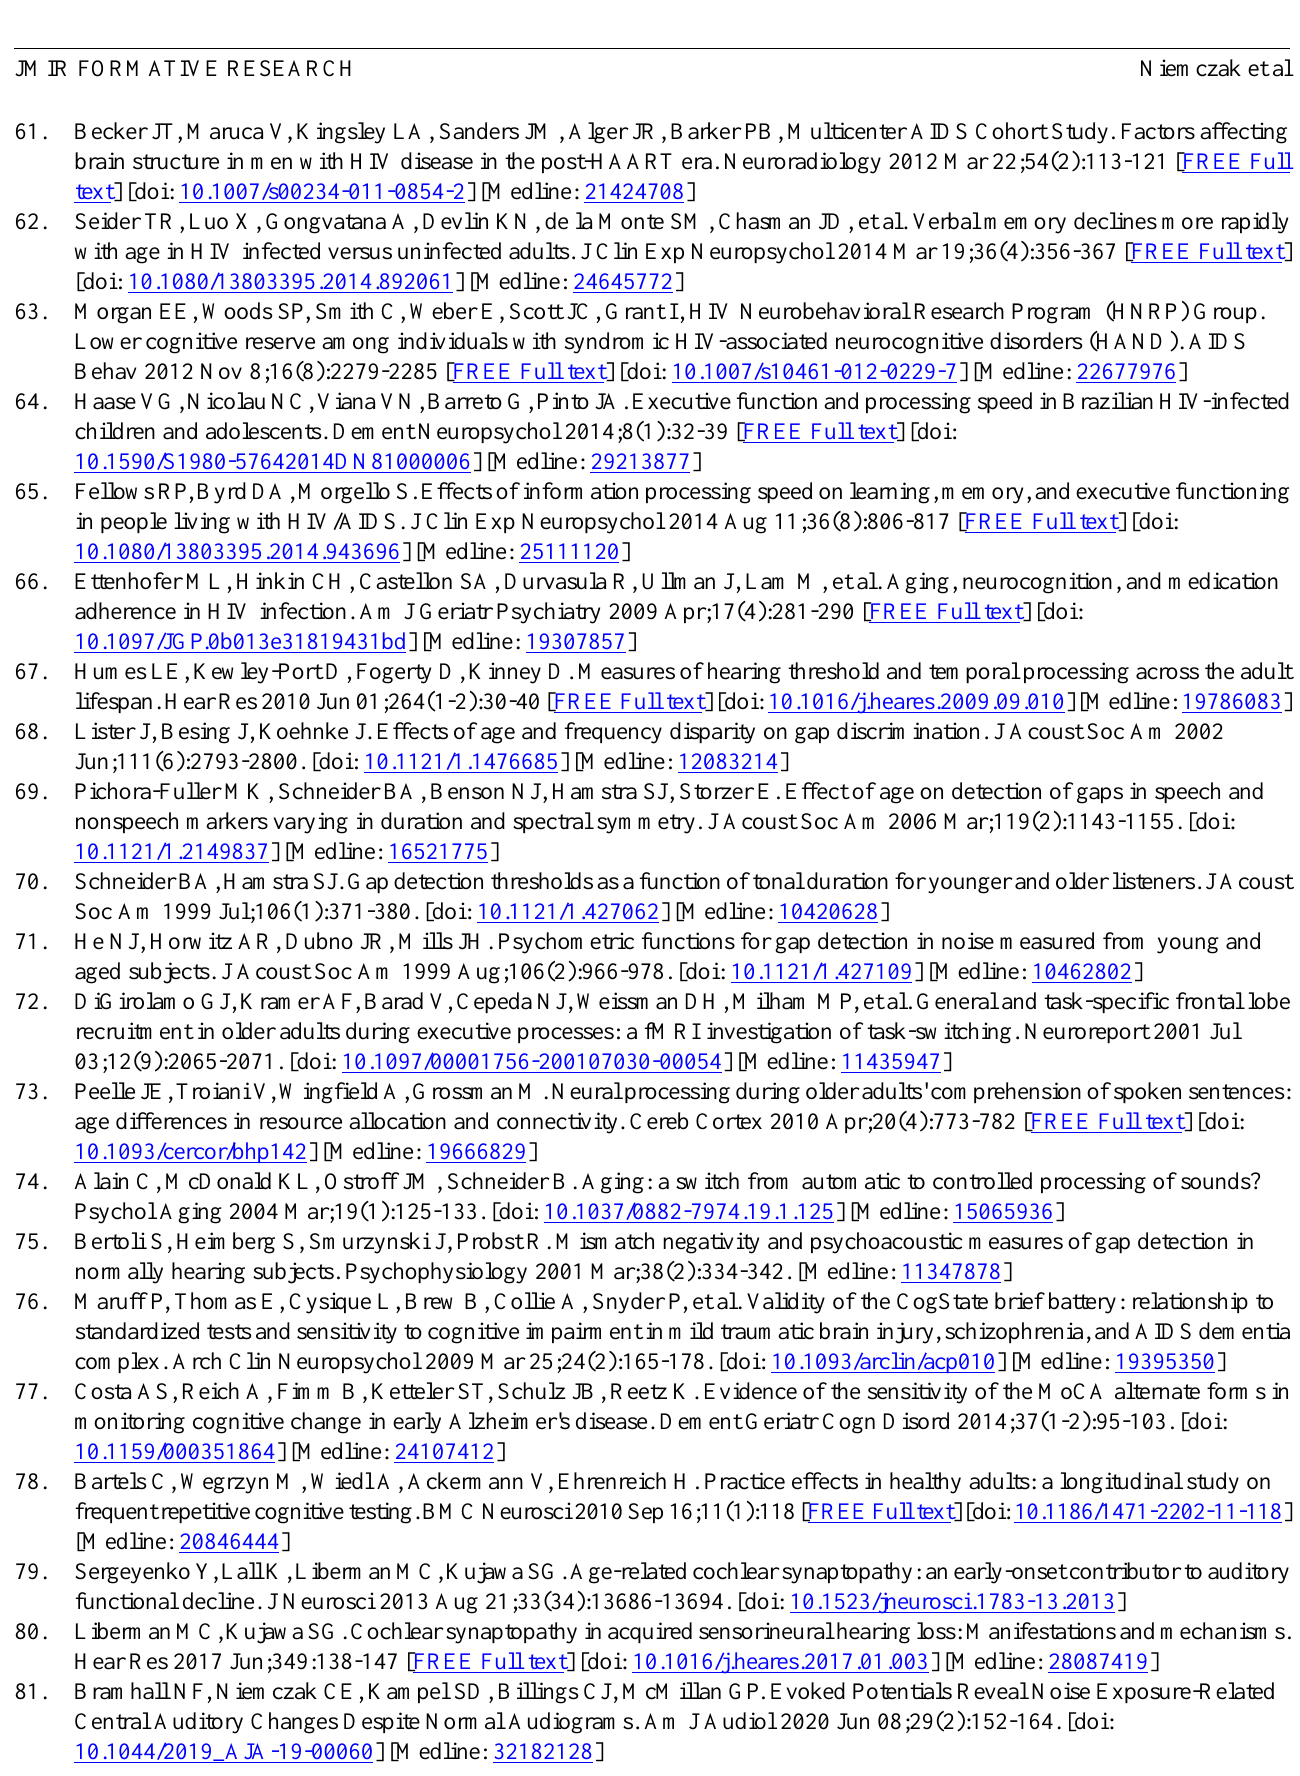
CAT: central auditory